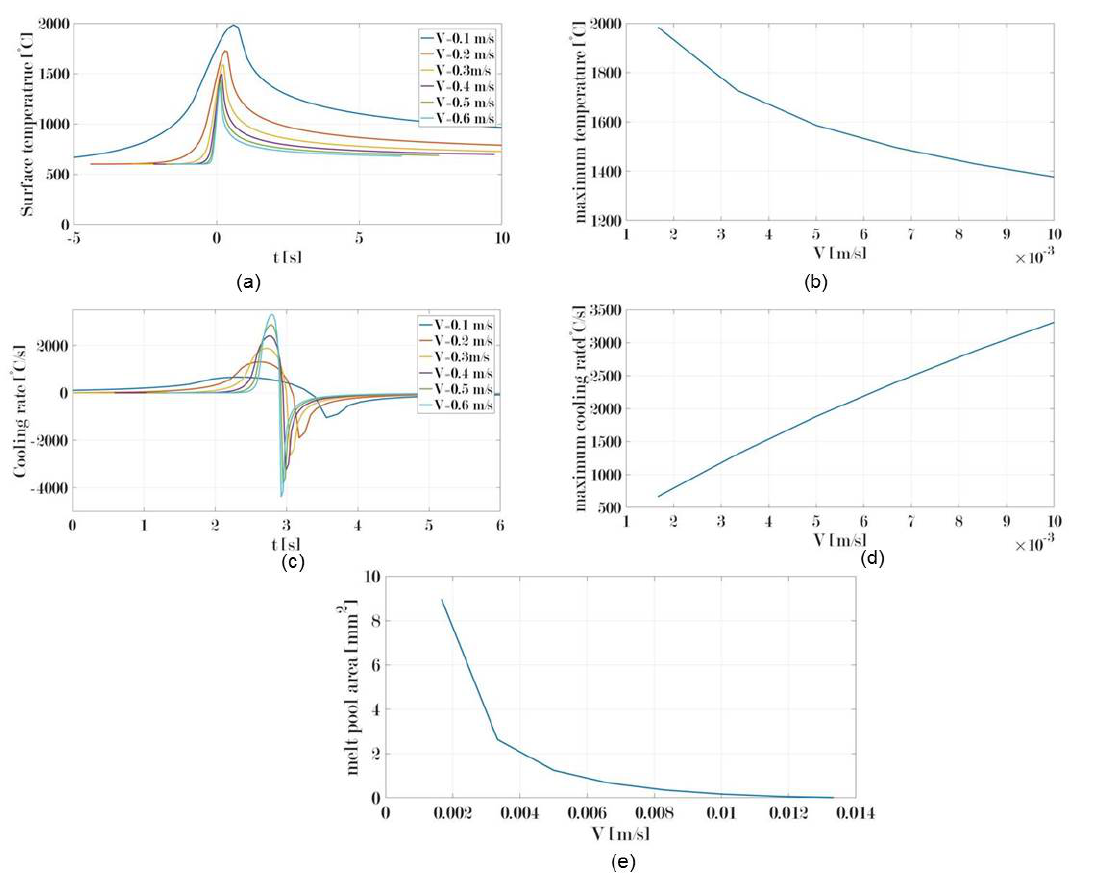
Figure 8. Simulation of the influence of the laser scanning speed on the temperature and on the melt pool cross section ( P = 400 W) ( a ) surface temperature for different scanning speeds; ( b ) evolution of the maximum surface temperature with the scanning speed; ( c ) surface cooling rate for different scanning speeds; ( d ) evolution of the maximum surface cooling rate with the scanning speed; and ( e ) evolution of the melt pool cross section with the scanning